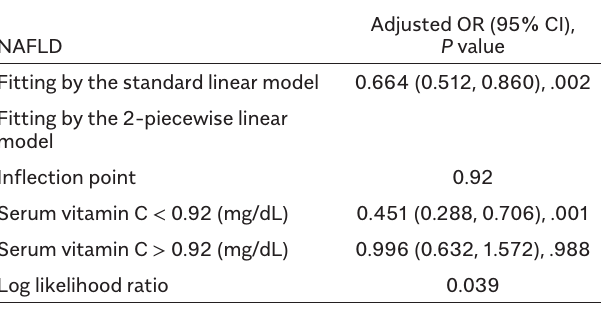
Table 3. Threshold Effect Analysis of Serum Vitamin C on NAFLD Using the 2 Piecewise Linear Regression